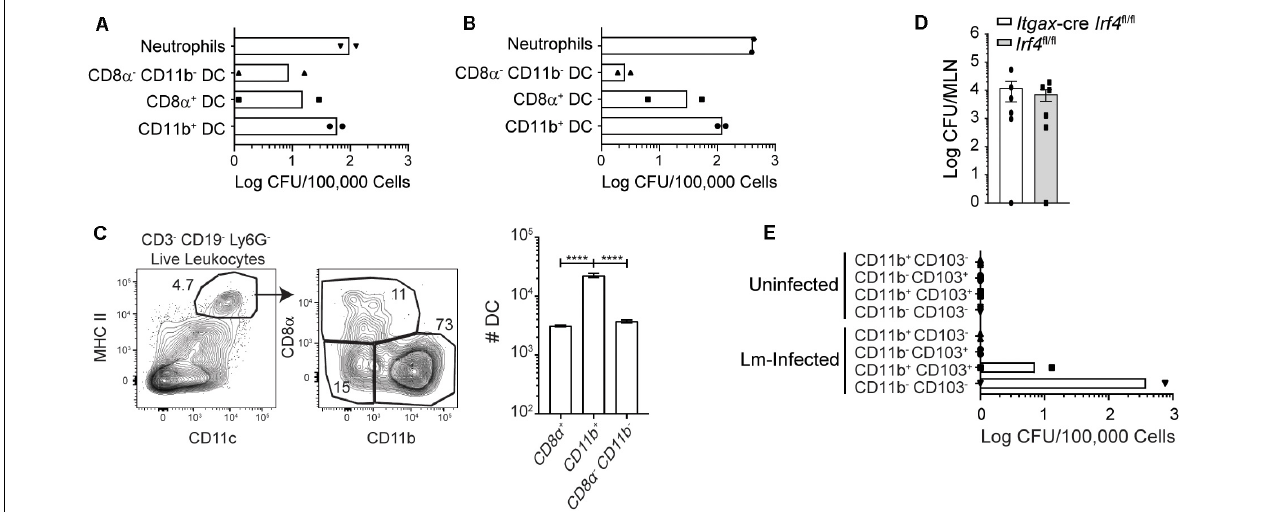
FIGURE 5 | Most InlA M Lm within DC subsets is associated with Batf3 -independent DC. (A,C) Mice were infected with 2 × 10 9 CFU InlA M Lm 10403s. (A) At 3 dpi, MLN from 10 Balb/c mice were pooled together for cell sorting. Sorted subsets were plated on BHI agar containing streptomycin, and bacterial burdens were enumerated 24–48 h later. DC subsets were distinguished based on their expression of CD8 α and CD11b. The graph depicts the mean and is cumulative of 2 independent experiments. Neutrophils were included as positive controls for both sets of experiments. (B) Balb/c mice were infected with 1 × 10 10 CFU InlA M Lm 10403s. At 3 dpi, 10 MLN were pooled together for cell sorting. Sorted DC subsets were plated onto BHI agar containing streptomycin, and burdens were enumerated 24–48 h after plating. The graph depicts the mean and is cumulative of 2 independent experiments. (C) MLN were harvested from Balb/c mice at 3 dpi, and dendritic cells subsets were analyzed via flow cytometry. Representative flow plots gated on B220 − TCR β − single, live leukocytes are shown. Graph depicts the quantification of dendritic cell subsets. (D) Itgax -cre Irf4 fl / fl and littermate ( Irf4 fl / fl ) controls were infected with 2 × 10 9 CFU InlA M Lm -OVA 10403s. At 3 dpi, MLN were harvested, processed in saponin, and plated on BHI agar containing streptomycin. Bacterial burdens were enumerated 24–48 h after plating. Data are cumulative of 2 experiments. (E) Mesenteric lymphadenectomy was performed on B6 mice. After 4–6 weeks of recovery, mice were infected with 2 × 10 9 CFU InlA M Lm 10403s, and thoracic duct cannulation was performed at 1 dpi. Migratory DC subsets were sorted from the recovered lymph fluid, plated onto BHI agar plates containing streptomycin, and bacterial burdens were enumerated 24–48 h later. One-way ANOVA with Bonferroni’s multiple comparisons test was used to analyze data. **** p <